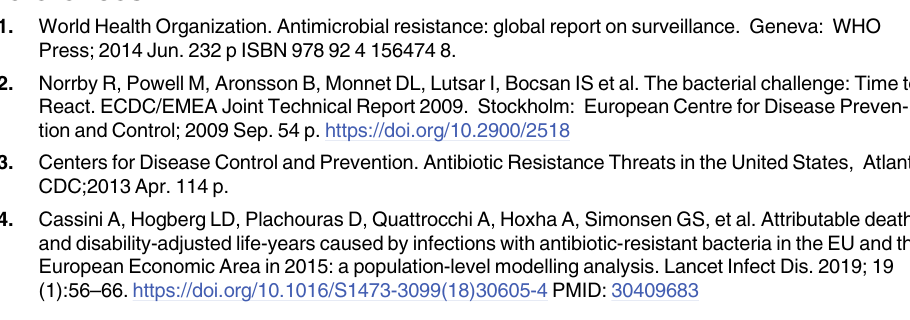
S1 Table. Mapped summary. S2 Table. Raw and relative read